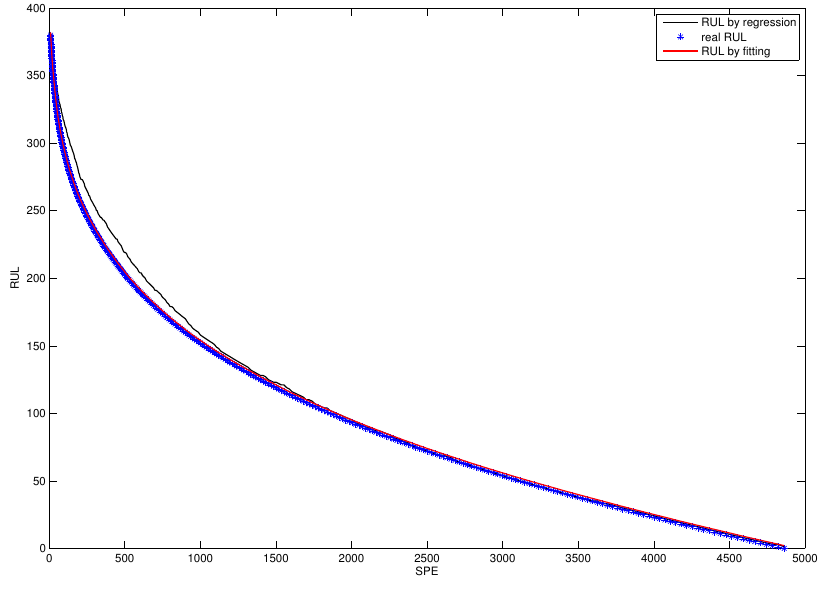
Figure 17. RUL prediction using AR to